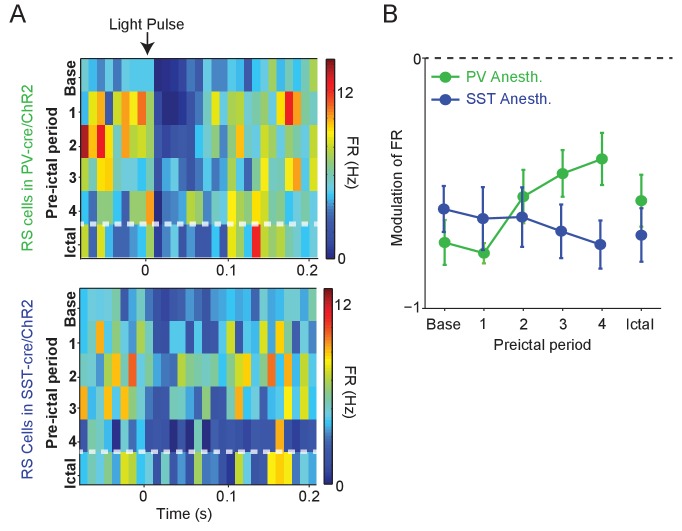
Modulation of RS firing by medium intensity stimulation of local inhibitory interneurons.(A) Upper: Average firing rate of RS cells (n = 11 cells in eight mice) recorded during PV/ChR2 experiments as a function of time (s) from laser pulse onset during baseline, the four preictal periods and a 60 s period following ictal onset after PTZ administration (see Materials and methods). Lower: Average firing rate of RS cells (n = 11 cells in seven mice) recorded during SST/ChR2 experiments as a function of time (s) from laser pulse onset during baseline, the four preictal periods and following ictal onset. For these plots, we considered only light pulses of mediumlight intensity (see Materials and methods). (B). Mean modulation of firing rate (see Materials and methods) after medium-intensity laser pulse (0 to 50 ms) compared to pre-pulse (−200 to 0 ms) firing rate for RS cells recorded during PV/ChR2 (green) and SST/ChR2 (blue) experiments. Modulation scores for RS in PV-Cre and RS in SST-Cre were significantly different from zero for all periods.